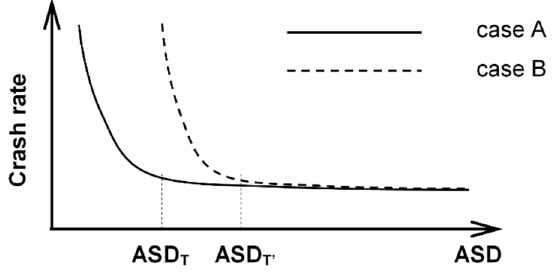
Figure 1. Conceptual relationship between available sight distance (ASD) and crash rate (adapted from [2]).